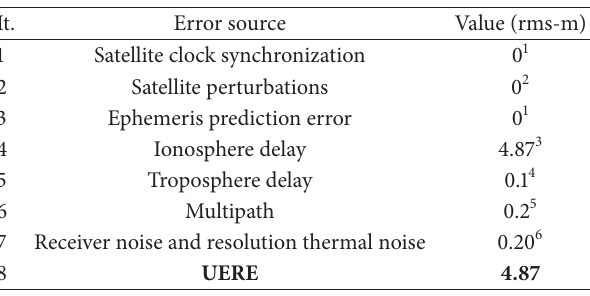
Table 6: UERE figure for GPS L1 receiver. FRPA pattern: cosine